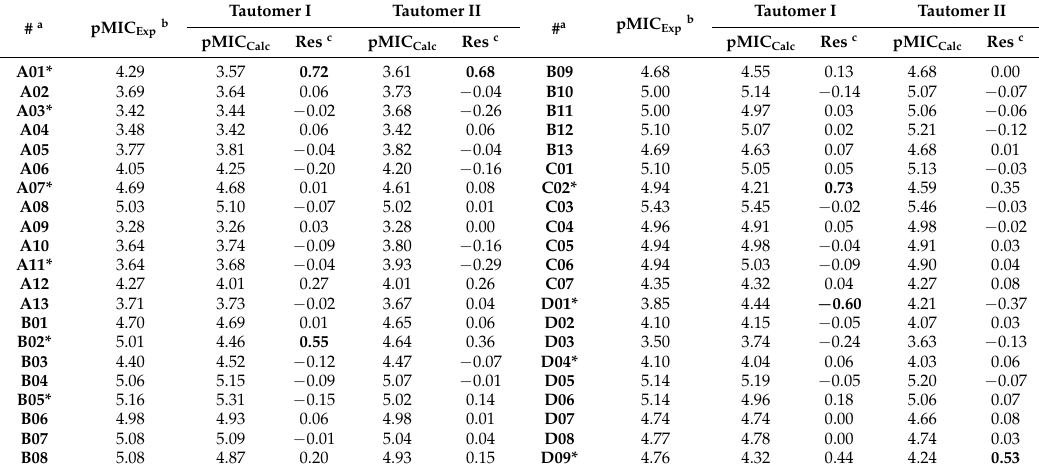
Table 6. Experimental pMIC (pMIC Exp ), calculated pMIC (pMIC Calc ), and residual (Res = pMIC Exp − pMIC Calc ) values of the tautomers I (amino) and II (imino) data sets using the best HQSAR models.